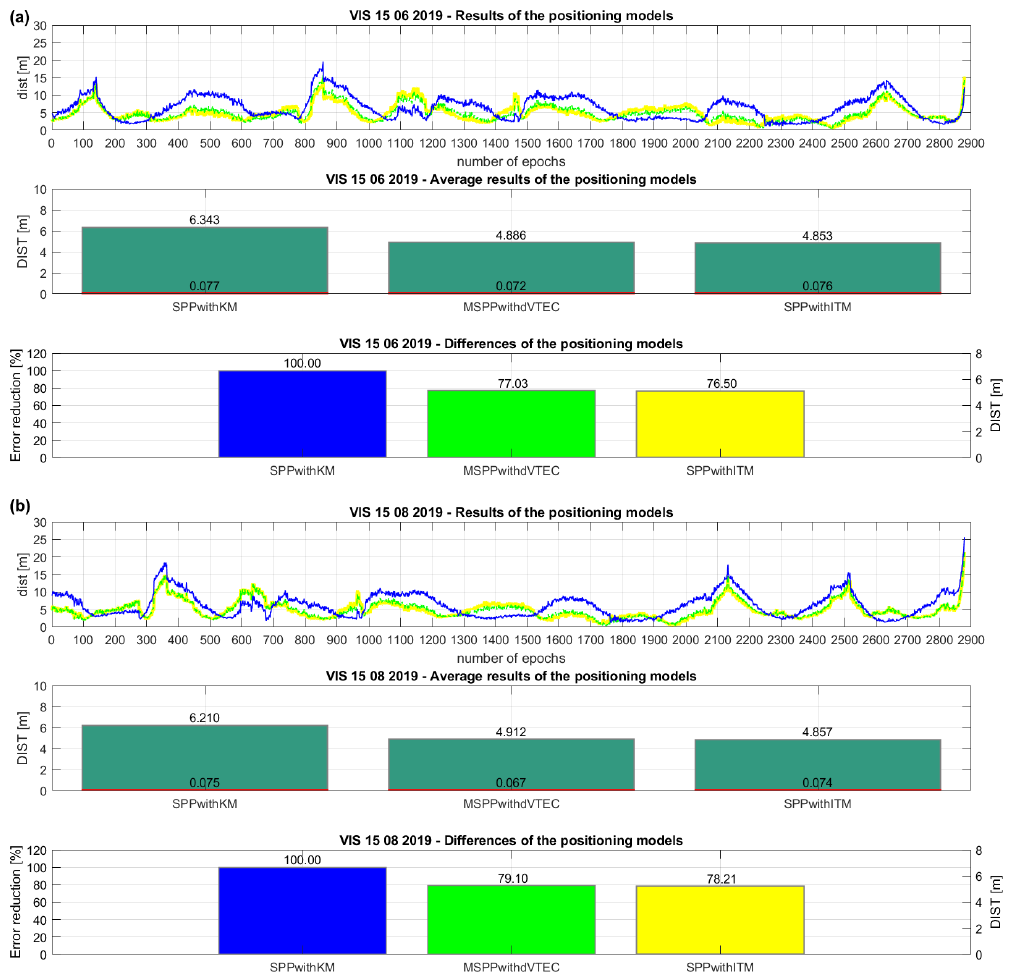
Figure 1. Set of the results of the positioning models: (a) VIS 15 June 2019 and (b) VIS 15 August 2019.